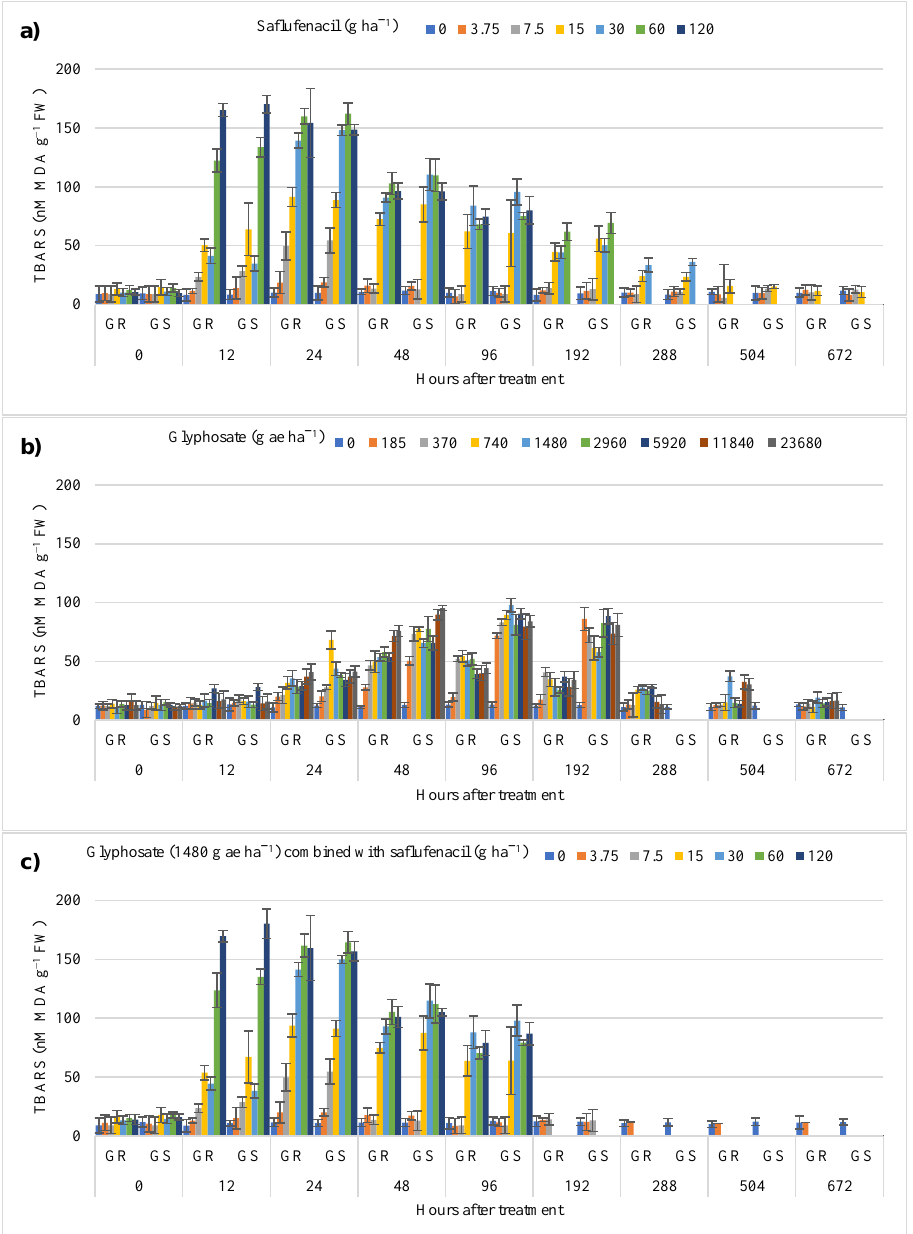
Figure 5. Time-course results of tissue damage (thiobarbituric acid reactive species, TBARS) in glyphosate-resistant (GR) and -sensitive (GS) Conyza bonariensis biotypes in response to treatment with (a) saflufenacil (untreated, 3.75, 7.5, 15, 30, 60, and 120 g ha −1 ), (b) glyphosate (0, 185, 370, 740, 1480, 2960, 5920, 11,840, and 23,680 g ae ha −1 ), and (c) glyphosate (1480 g ae ha −1 ) combined with saflufenacil rates (untreated; 3.75, 7.5, 15, 30, 60, and 120 g ha −1 ). The interval bars represent 95% confidence intervals (CI). Individual comparisons between biotypes in each respective herbicide rate and time after treatments are presented in Tables S1–S3. Regressions are presented in Tables S4–S6.